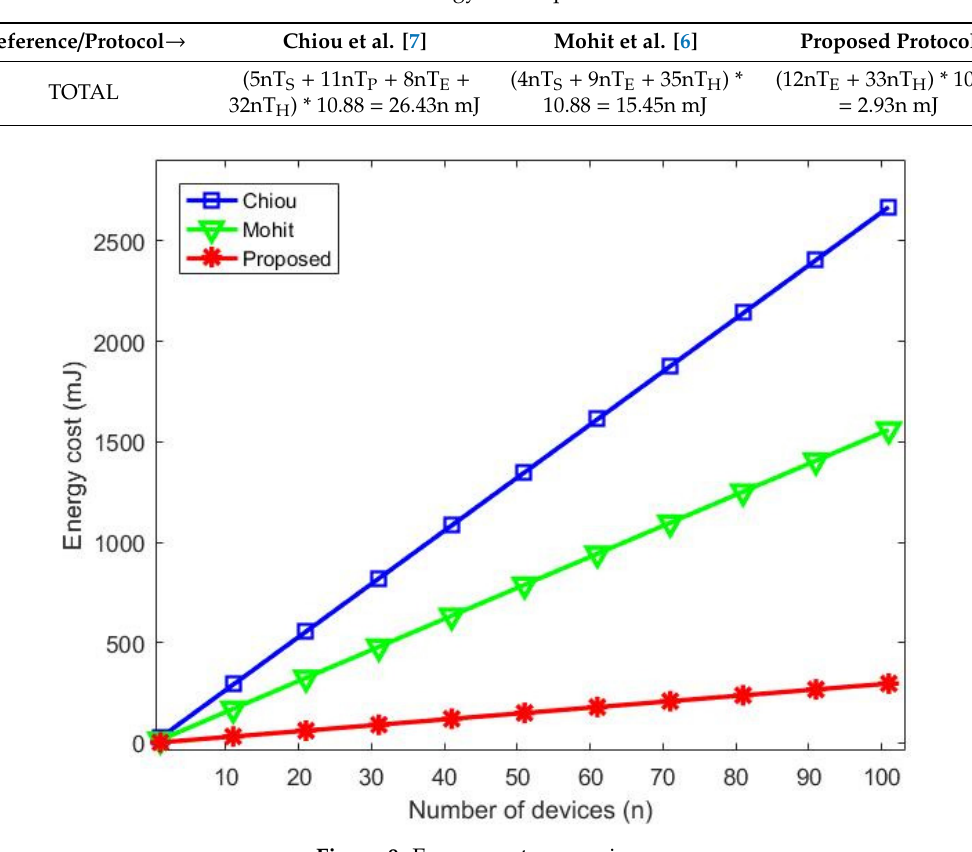
Figure 9. Energy cost comparison.